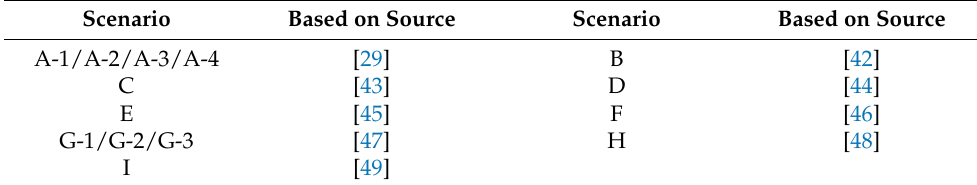
Figure 3. Ramp-up trajectories of photovoltaic power development scenarios for Germany based on [41]. Table 3. Studies used as a basis for the development of heat